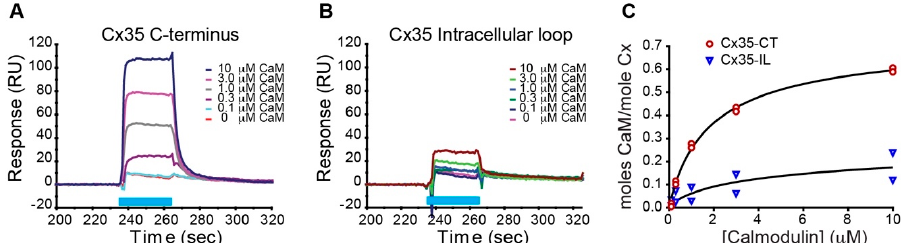
Figure 2. Surface plasmon resonance analysis of calmodulin binding to Cx35 C-terminal and Intracellular loop domain GST-Sumo fusion proteins. ( A , B ) Reference (GST-Sumo)-subtracted response traces